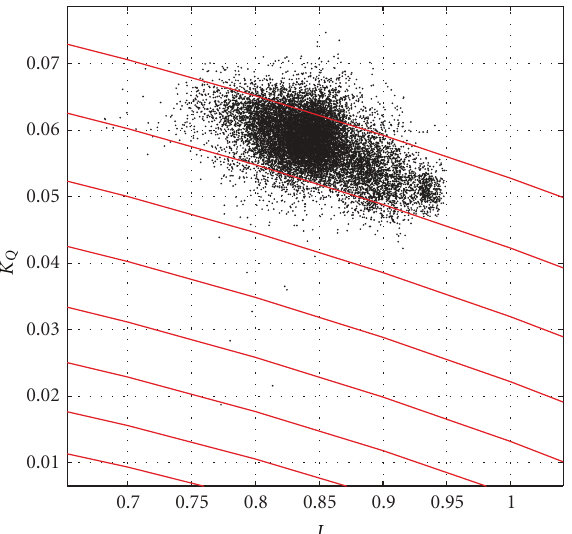
Figure 5: Points whose pitch was larger than 95% of the maximum pitch.